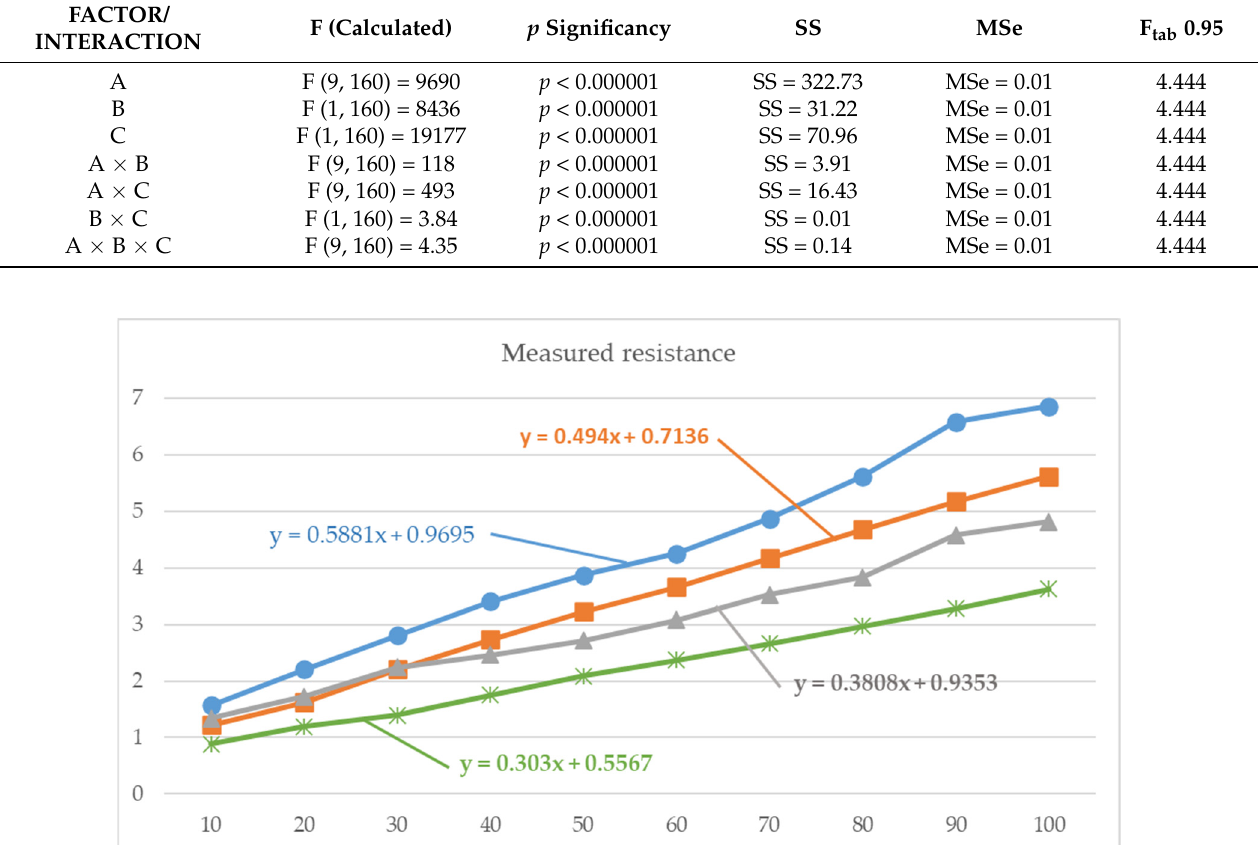
Table 8. ANOVA statistical evaluation output.